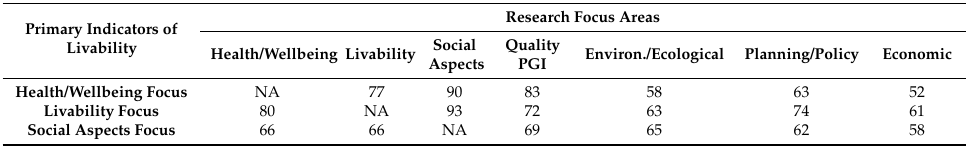
Table 3. Percentage of articles reporting on the research focus for articles identified in the initial search of this reviewer that reported on the contribution that PGI makes to urban livability (n = 71). Percentages add to greater than 100% as articles that report multiple research focus areas are reported in more than one category.